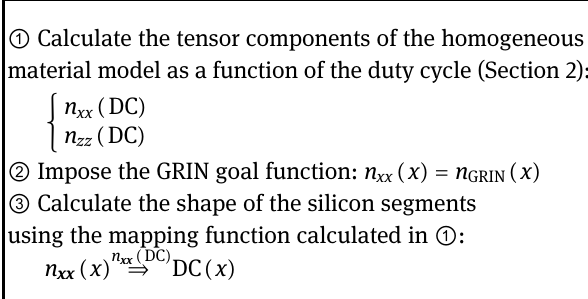
SWG metamaterial index design